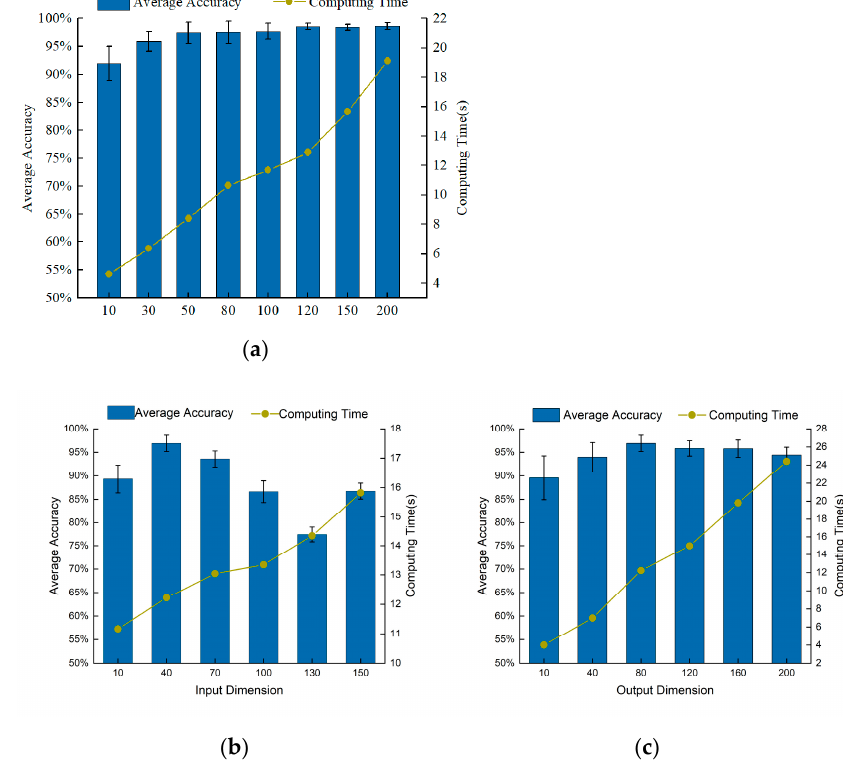
Figure 3. Influence of various parameters on diagnostic performance of GSLSF. ( a ) Number of segments. ( b ) Input dimension. ( c ) Output dimension.